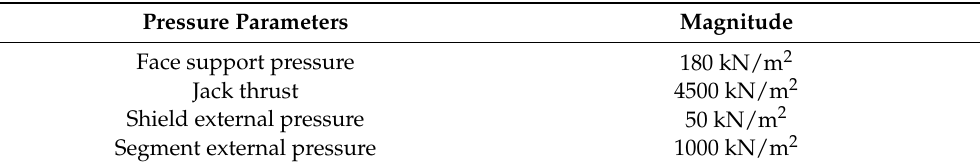
Table 3. Pressure parameters used in the finite element analyses to model TBM excavation.